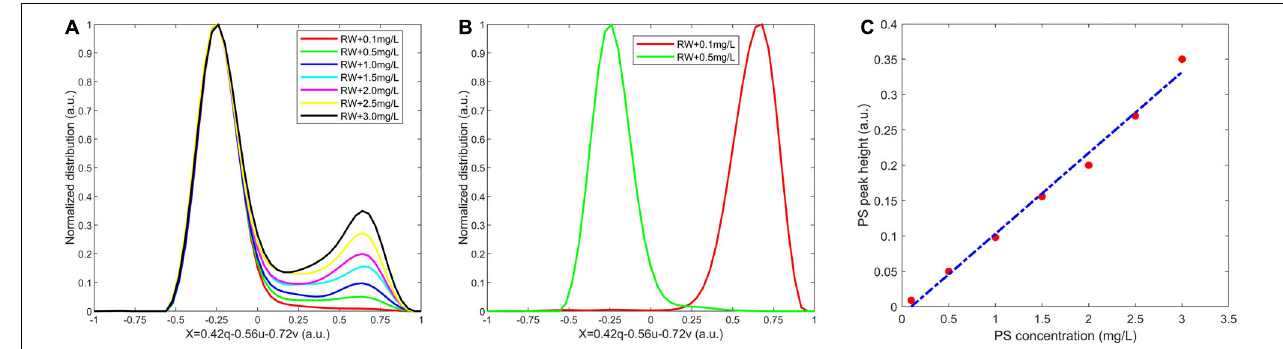
FIGURE 2 | Distribution of river water and 10-micron spherical polystyrene (PS). (A) Mixing experiment of river water and different concentrations of 10-micron spherical PS. (B) Individual experimental data. (C) Quantitative graph of PS with increasing concentration.